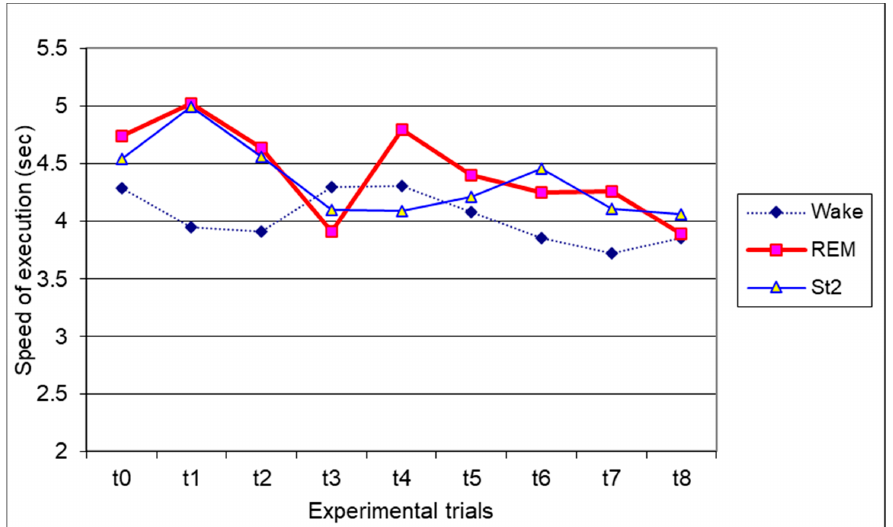
Figure 2. Graphical representation of the interaction between the experimental condition and experimental trial of the speed of execution (in sec) of the finger tapping task. Means are reported.